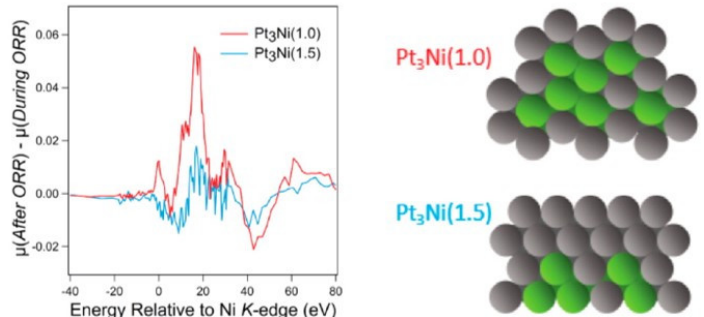
Figure 10. In situ Ni K-edge X-ray absorption near edge structure (XANES) subtracted from ex situ XANES after electrochemical process of NiPt/C nanoframes. One the right shows deducted surface atomic models of two as-prepared samples, where gray atoms are Pt and green atoms are Ni. Refer sample notation to original paper. Reprinted with permission from reference [87]. Copyright 2015 American Chemical Society.